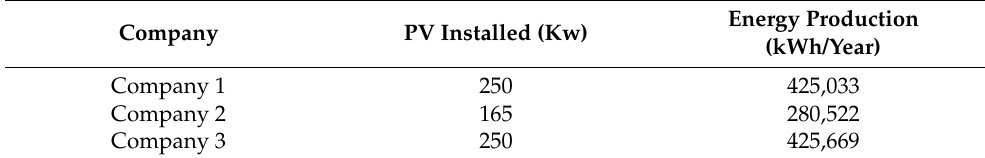
Table 4. PV systems capacities and productions (for the three